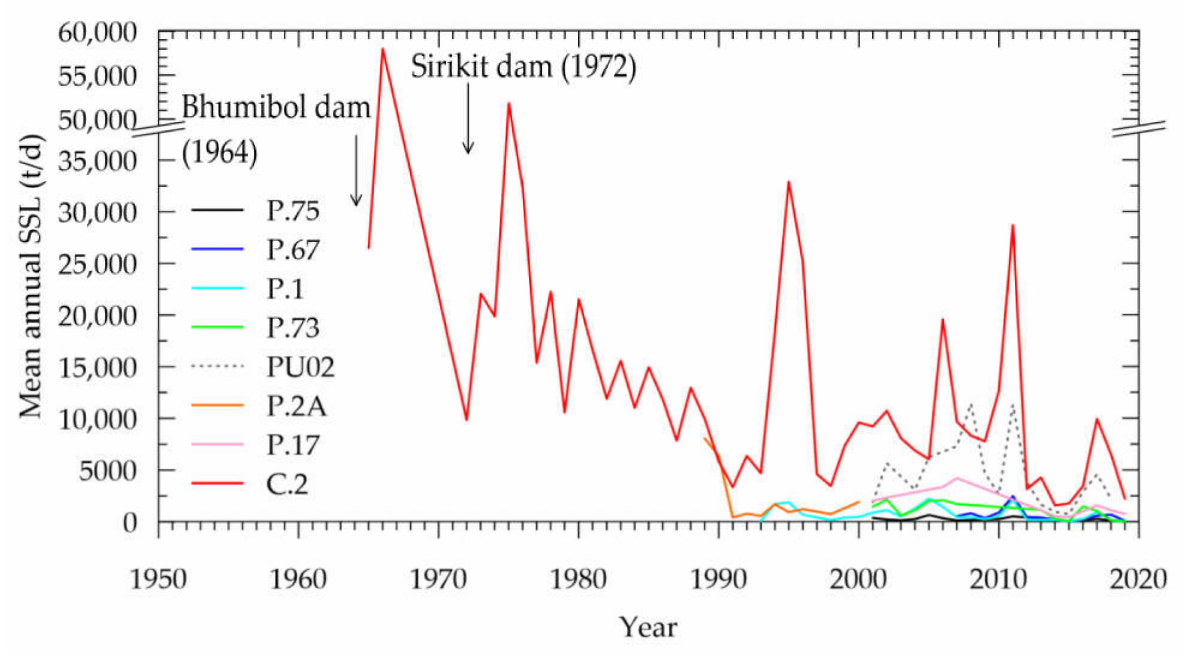
Figure 4. Time series data of annual suspended sediment load at RID hydrological stations along the Ping River between 1965 and